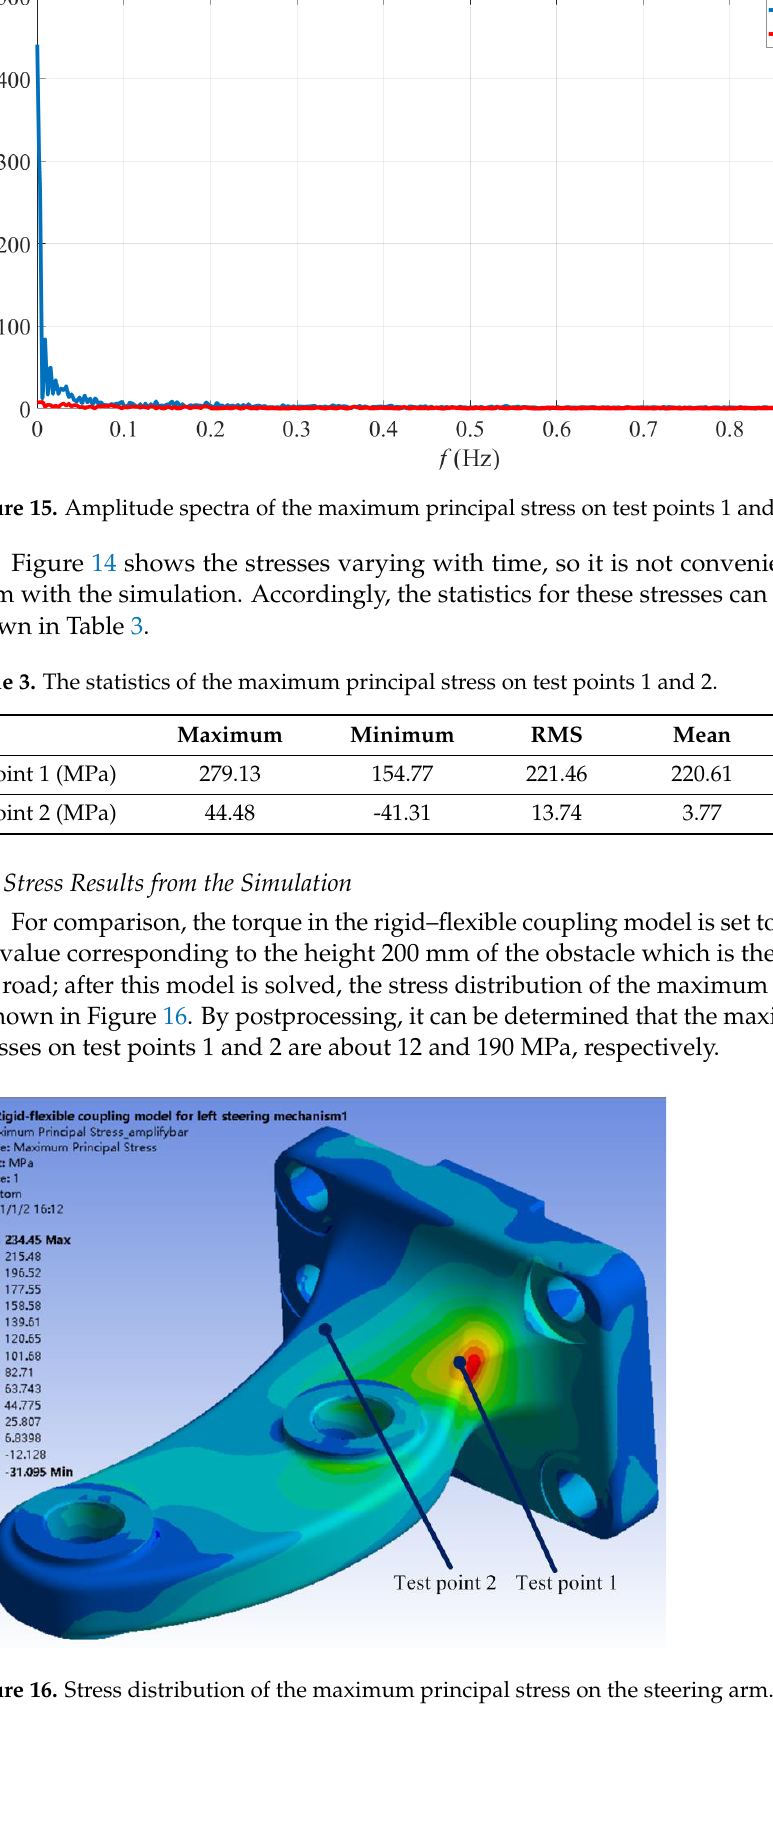
Figure 14. Responses of the maximum principal stress on test points 1 and 2.